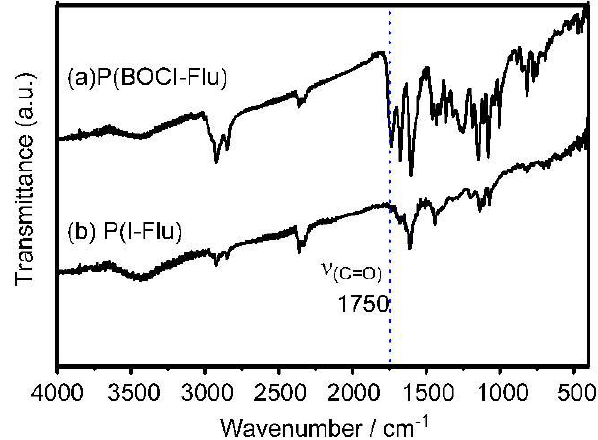
COOH-treated) 3 in air. 2